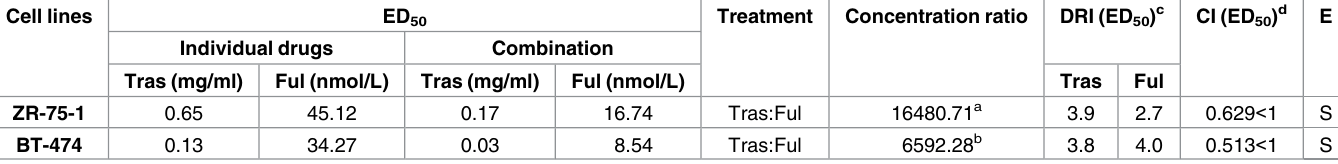
Table 1. Combinatorial use of trastuzumab and fulvestrant (CalcuSyn). Cell lines